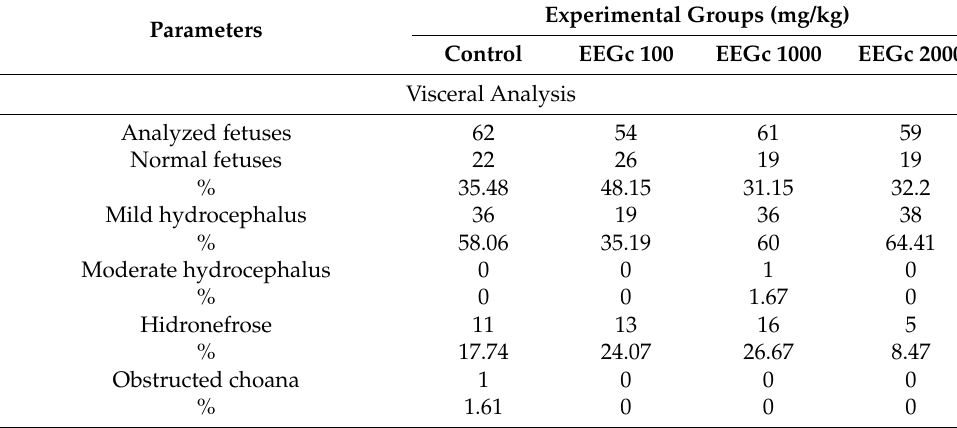
Table 5. Visceral malformations found in the offspring of females treated with the G. celosioides ethanolic extract